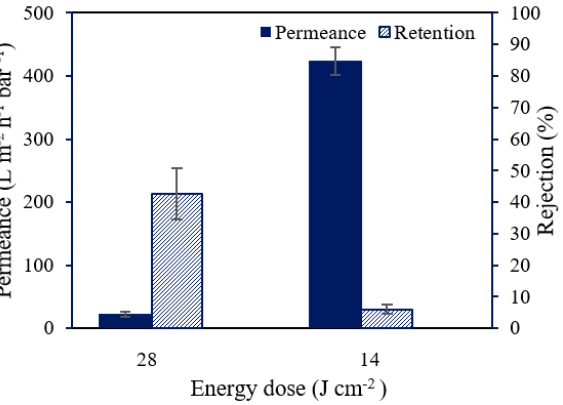
Figure 5. The effect of energy dose on the performance of the UV-cured PSf supports. Both mem- branes were prepared from a solution containing 10 wt% PSf, 2 wt% XL, and 0.3 wt%